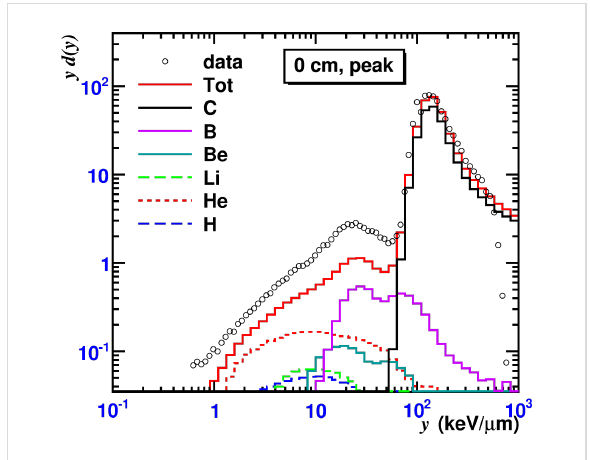
Figure 6: Contribution of various fragments to the microdosimetry spectra measured on the beam axis in the Bragg peak region in a water phantom irradiated by 300 A MeV 12 C nuclei. Histograms repre- sent MCHIT calculations. Data points from